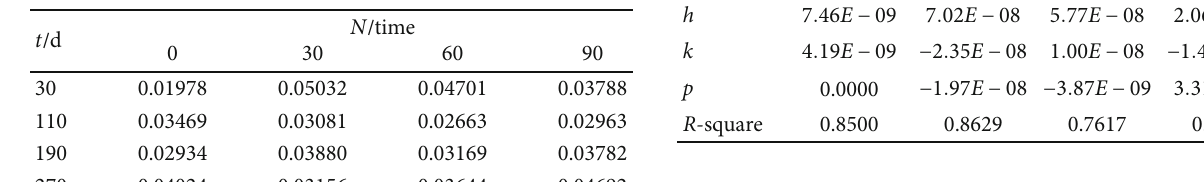
Table 4: Values of the parameter ε and corrosion time.